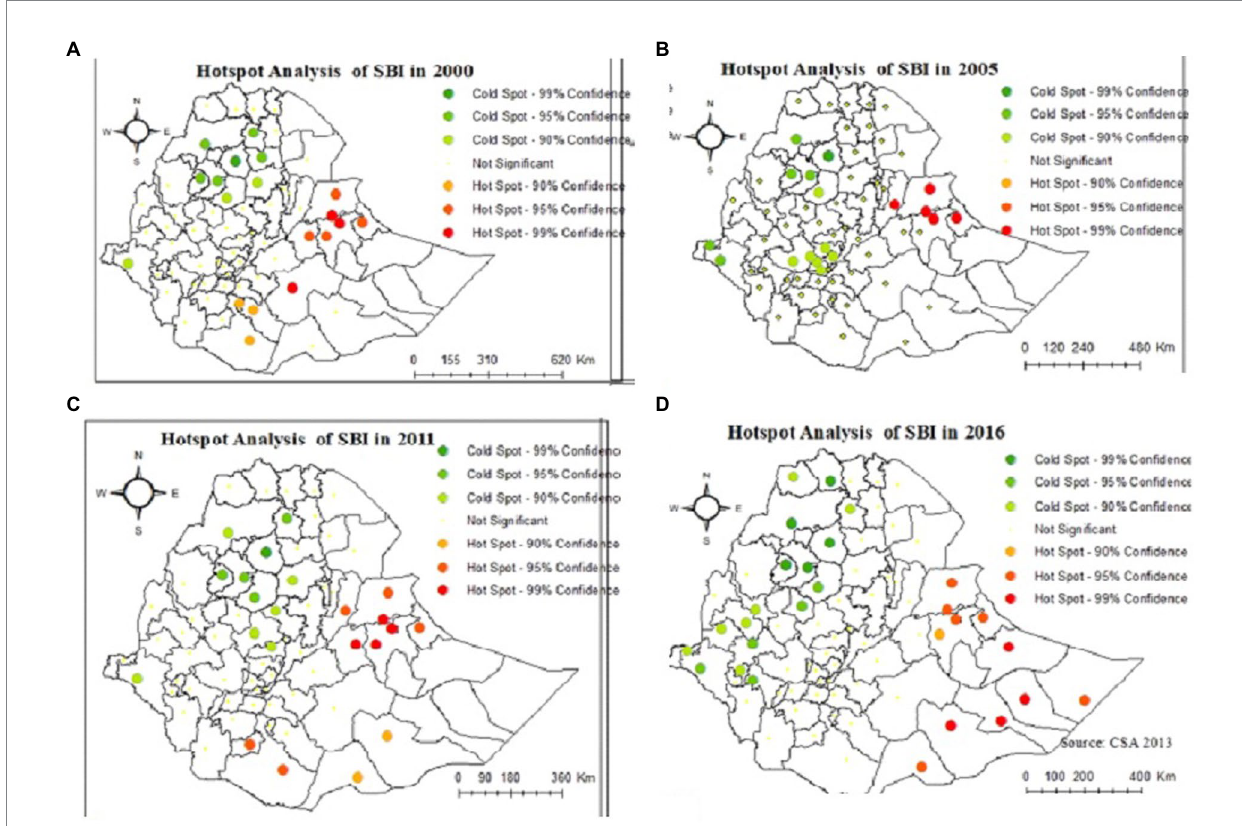
FIGURE 3 Hot spot and cold spot administrative zones of short birth intervals in Ethiopian in the years (A) 2000, (B) 2005, (C) 2011, and (D)